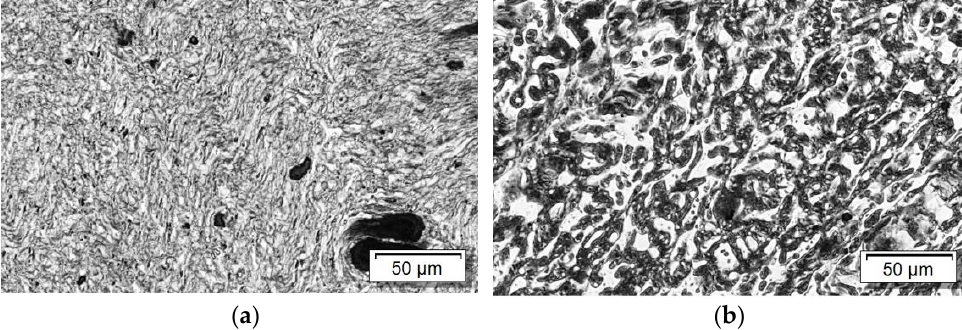
Figure 6. LM images of ( a ) PA6/SAN 50/50 + 3 wt.% SWCNT and ( b ) PA6/PMMA 50/50 + 3 wt.% SWCNT, at higher magnification.